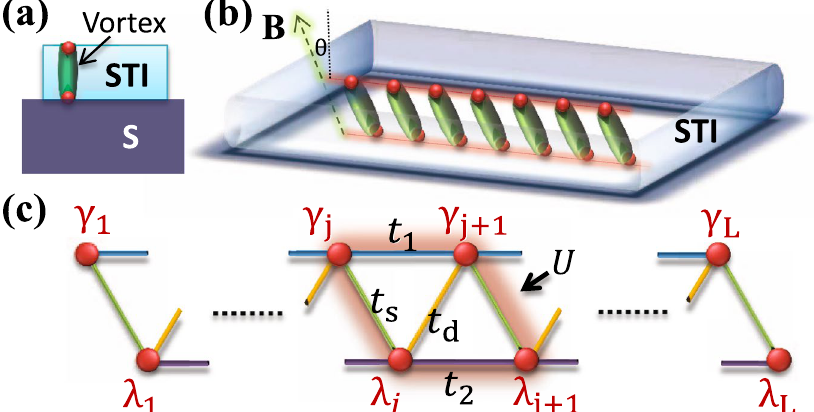
Figure 1. Experimental setup for a Majorana ladder. ( a ) Illustration of a pair of Majorana fermions (red dots) embedding respectively in the top and bottom of a vortex line (green tube) in a strong-topological-insulator thin film (STI, light-blue region) on an s -wave superconductor (S, dark-blue regions). ( b ) An array of vortices in the heterostructure, forming a two-leg Majorana ladder. An applied magnetic field B (dashed arrow) lines up vortices with angle θ and hence tilts the ladder system. ( c ) The tight-biding model for the Majorana ladder, describing top-chain ( γ ) and bottom-chain ( λ ) Majorana fermions coupled by intra-leg tunnelings t 1 γ i γ i + 1 and